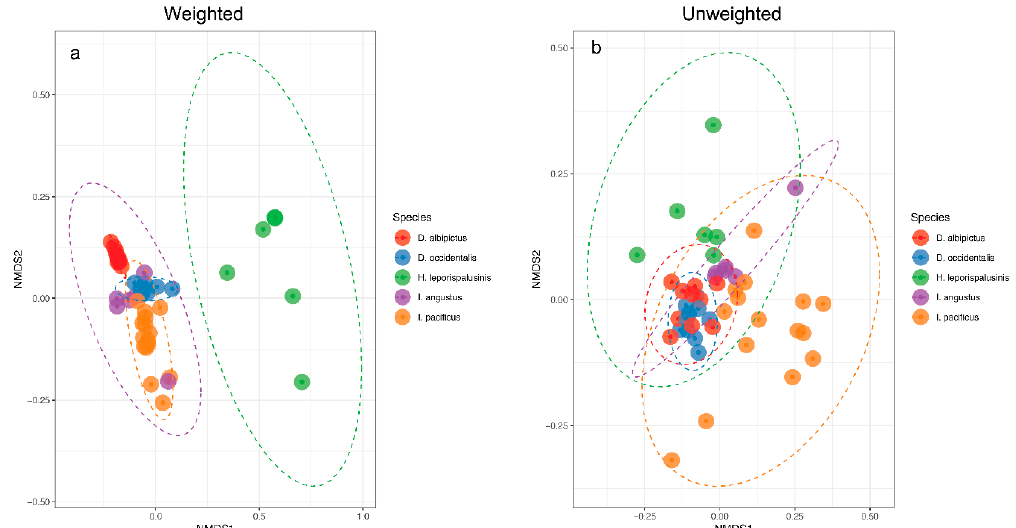
Figure 2. Microbiome representation of larvae by species. ( a ) Weighted and ( b ) Unweighted non-metric multidimensional scaling (NMDS) by species at the larval life stage. Ellipses represent a 95% confidence interval around the centroid of each group.